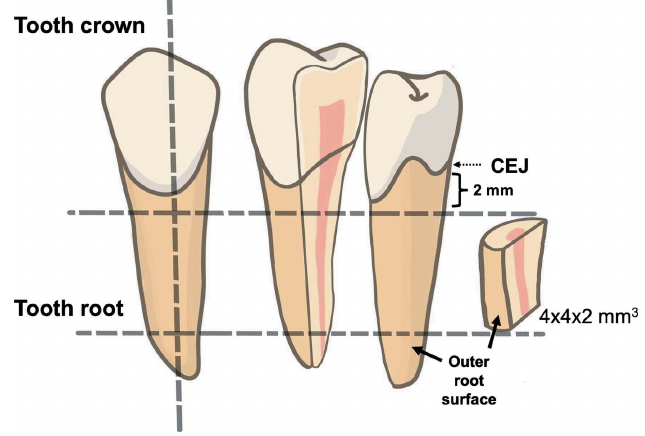
Figure 1 Sectioning of a human premolar to obtain a root dentin specimen for further